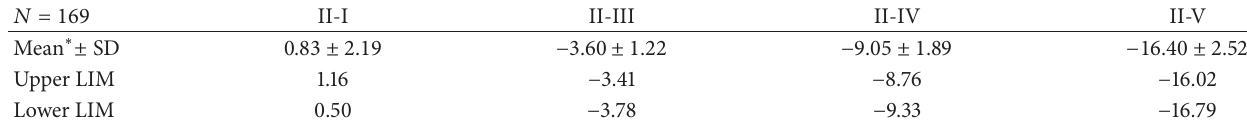
Table 2: Mean values of metatarsal protrusion related to II ray (in percentage terms). Whole specimen.